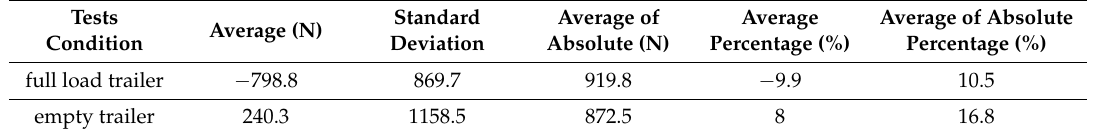
Table 6. Statistical analysis of the system error.